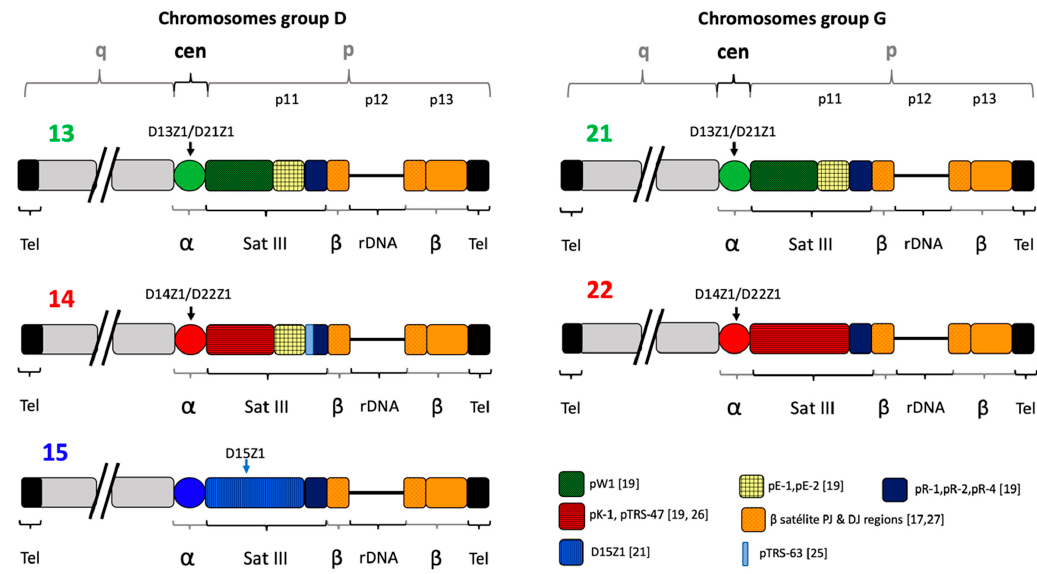
Figure 1. Schematic representation of the sequences on the short arms of human acrocentric chromosomes. Organization of β satellite DNA according to Floustakou et al. [25] and Waye et al. [17]. The region comprising Satellite III pR-1, pR-2, pR-4, perinucleolar β satellite PJ and DJ, NOR and telomeric regions are shared by all acrocentric chromosomes. The most variable region is that of the proximal satellite III, although chromosomes 13, 14, and 21, on one hand, and chromosomes 14 and 22, on the other hand, share sequences. The only chromosome-specific sequence is the satellite III subfamily D15Z1, typical of chromosome 15p. Organization of the subfamilies of satellite III DNA according to Bandyopadhyay et al. [19], Jarmuz et al. [26], Higgins et al. [21], and Choo et al. [27]. Arrows indicate regions that were analyzed by Fluorescence In Situ Hybridization (FISH) in this study.